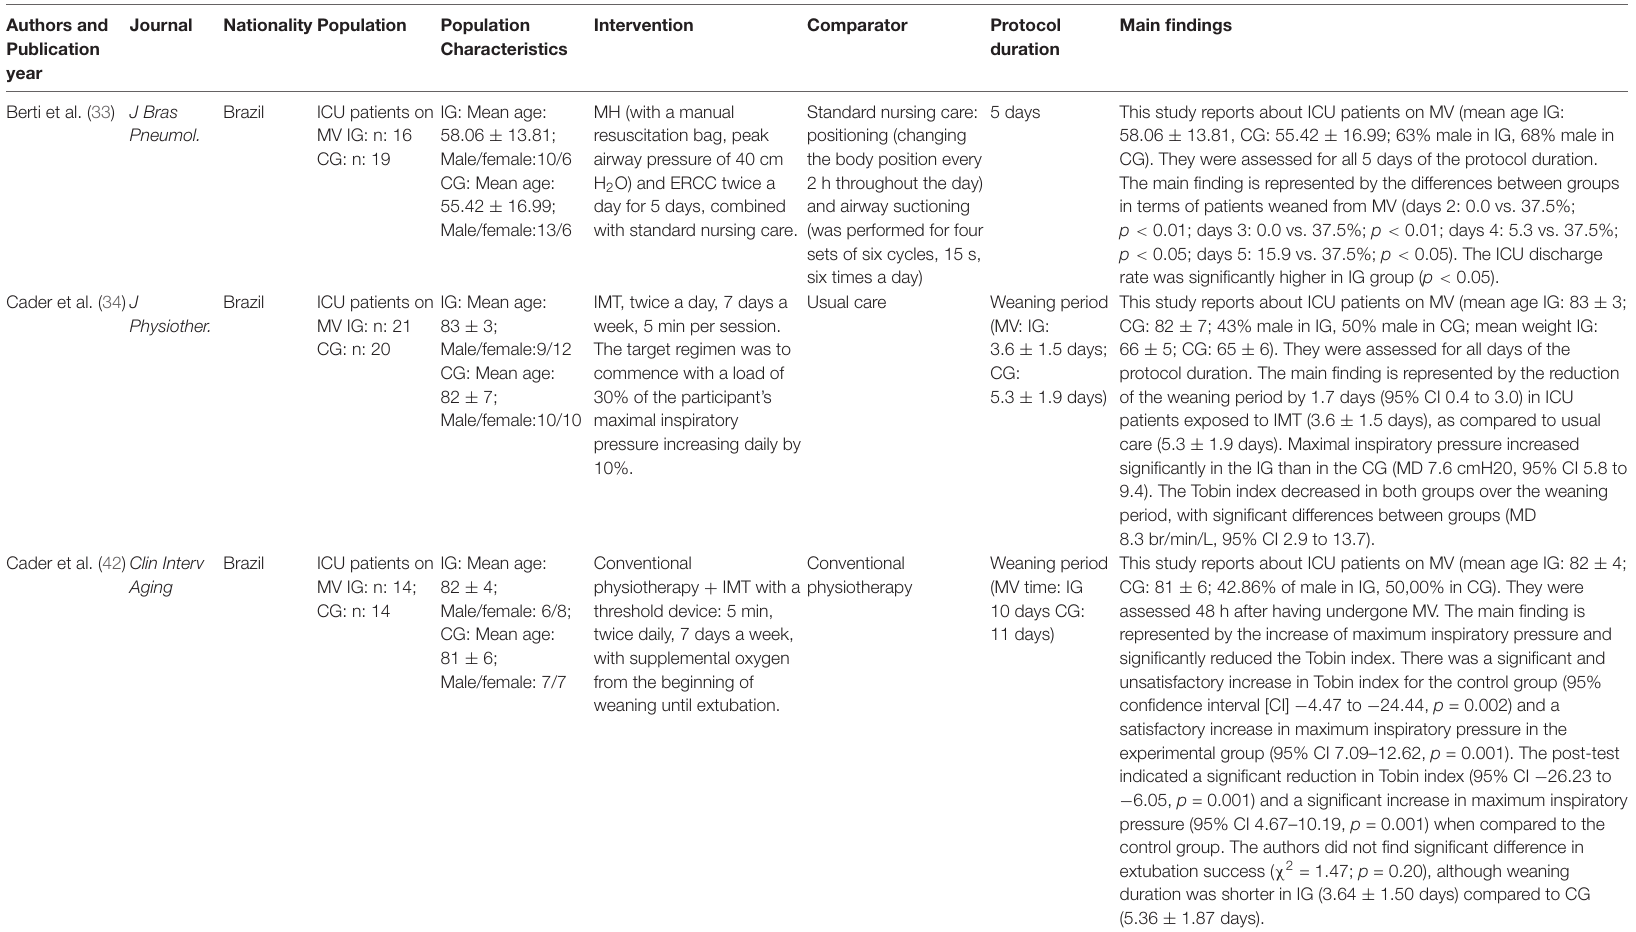
TABLE 1 | Main characteristics of the studies